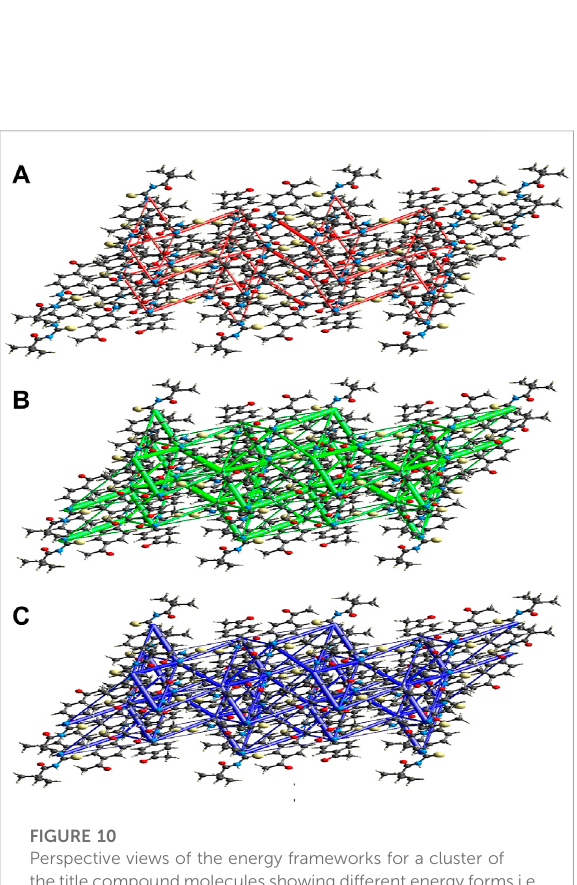
(cid:129)(cid:129)(cid:129) (cid:129)(cid:129)(cid:129) (cid:129)(cid:129)(cid:129) (cid:129)(cid:129)(cid:129) (cid:129)(cid:129)(cid:129) H, (B) H S/S H, (C) H C/C H and (D) H